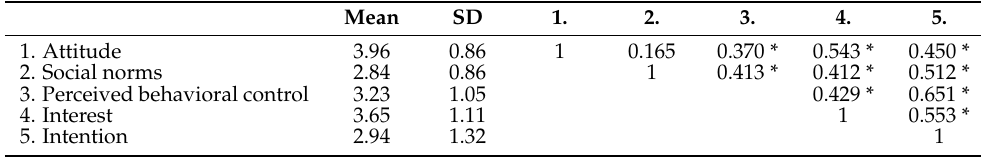
Table 5. Descriptive statistics and correlations for study variables.